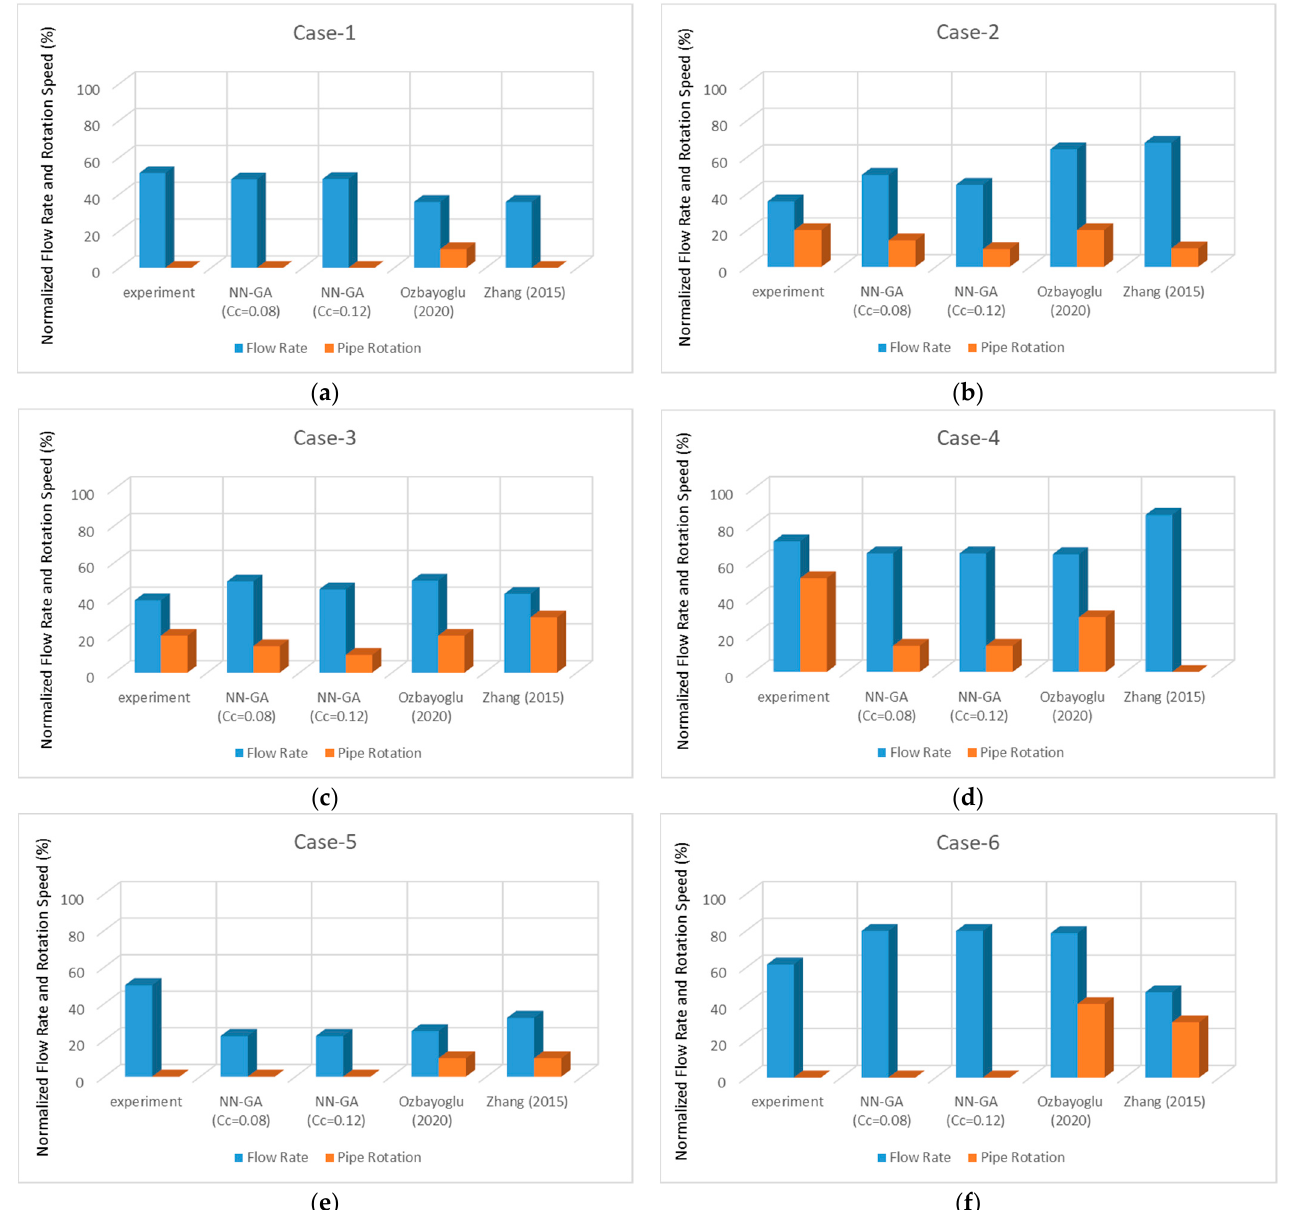
Figure 13. Summary of the comparison of optimal flow rates and pipe rotation speeds using the proposed machine learning approach, mechanistic models, and experimental data: ( a ) Case 1, ( b ) Case 2, ( c ) Case 3, ( d ) Case 4, ( e ) Case 5, and ( f ) Case 6.